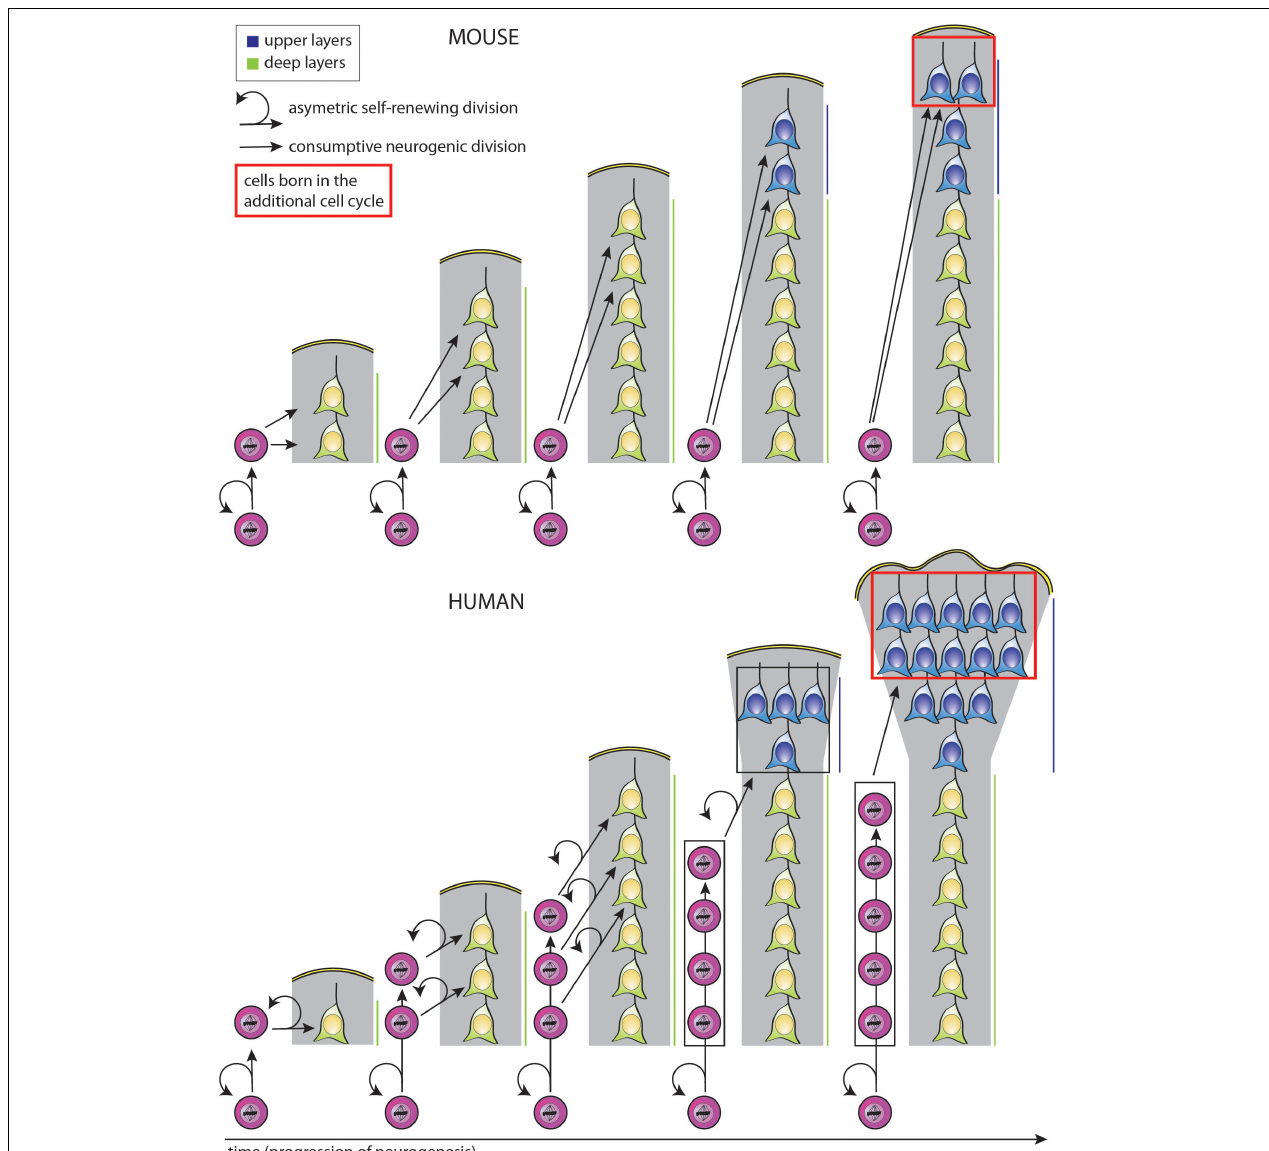
FIGURE 3 | Simplified model illustrating how a selective increase in upper-layer neurons in human as compared to mouse can be achieved by changing the type of BP generated from aRG and the mode of BP division, with the same temporal progression regarding the change from deep-layer to upper-layer neuron generation. In both mouse (top) and human (bottom), aRG (bottom cells in each diagram) undergo repeated cycles of asymmetric, self-renewing and BP-genic, division. However, the type of BP generated and its mode of division over the course of neurogenesis are different. Top: With each cycle of asymmetric self-renewing division (round arrows), an aRG in embryonic mouse neocortex generates one bIP (straight vertically pointing arrows), which then undergoes consumptive neurogenic division, generating two neurons (pairs of straight oblique arrows). This leads to a linear increase in the total number of neurons generated, with two neurons added per single aRG division cycle. Bottom: With each cycle of asymmetric self-renewing division (round arrows), an aRG in fetal human neocortex generates one bRG (straight vertically pointing arrows). This undergoes repeated cycles of asymmetric, self-renewing division (round arrows), with the other daughter being a neuron (straight oblique arrows). As each bRG persists due to self-renewal, this leads to a linear increase in the number of bRG with each aRG cycle. This in turn leads to a progressive increase in the number of neurons generated per aRG cycle, which is equal to that in mouse after the 3rd aRG cycle, that is, an equal number of deep-layer neurons has then been generated in both the mouse and human scenario. However, if we assume that for both mouse and human, BPs switch to generate upper-layer neurons in the 4th aRG cycle, due to the accumulation of bRG in human, a greater number of upper-layer neurons in generated in this cycle in human than mouse. This difference becomes even greater if in the next cycle, the bRG in human, like the bIPs in mouse, adopt a consumptive neurogenic mode of division (red boxes), perhaps via the generation of bIPs (not illustrated; for a more detailed depiction of possible BP lineages, see Lewitus et al., 2014). Comments : (i) Hence, lengthening the neurogenic period, e.g., from the 4th to the 5th aRG cycle, results in a selective increase in upper-layer neurons for both mouse and human; (ii) a lineage of asymmetric self-renewing BP-genic aRG division followed by asymmetric self-renewing neurogenic bRG division followed by consumptive neurogenic bRG division (see above) results in a greater upper-layer neuron output in human than the lineage of asymmetric self-renewing BP-genic aRG division followed by consumptive neurogenic bIP division in mouse.